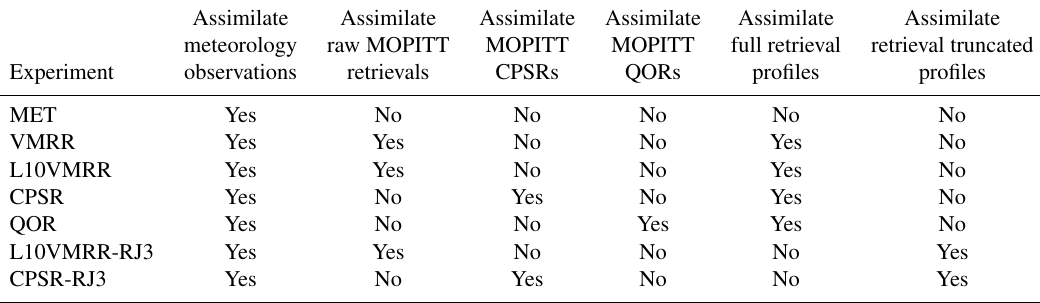
Table 1. Summary of the WRF-Chem/DART forecast/data assimilation experiments. Assimilate Assimilate Assimilate Assimilate Assimilate Assimilate meteorology raw MOPITT MOPITT MOPITT full retrieval retrieval truncated Experiment observations retrievals CPSRs QORs profiles